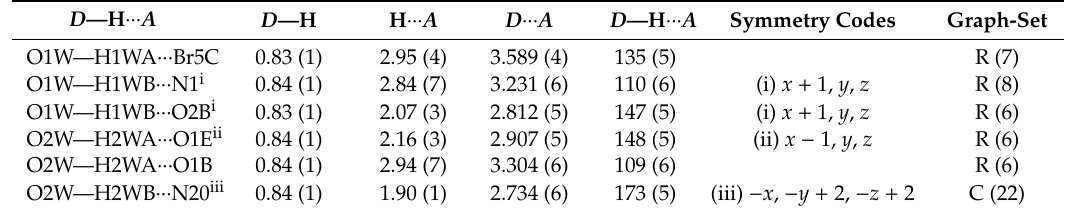
Table 3. Hydrogen-bond geometry (Å, º) for compound 1.